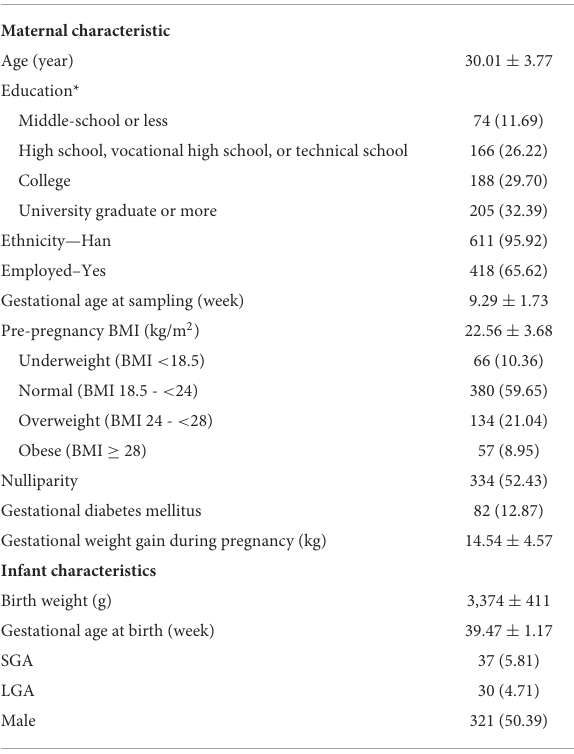
TABLE 1 Distribution of maternal and fetal characteristics in study population ( n =